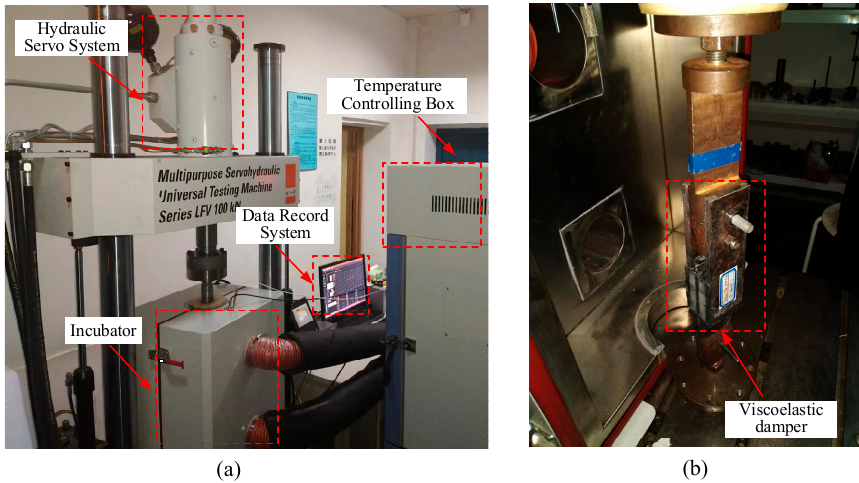
Figure 1. Dynamic properties tests of the viscoelastic damper. ( a ) Schematic diagram of the dynamic test. ( b ) Viscoelastic damper inside the incubator. Table 1. Conditions of the dynamic performance tests.